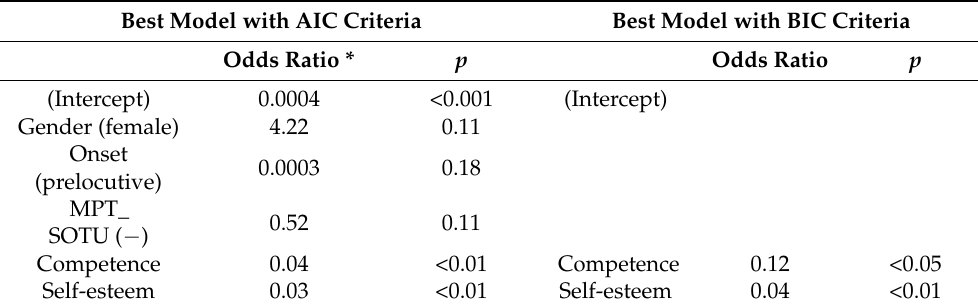
Table 4. Logistic regression coefficients (transformed to odds ratio) for two alternative models to predict abandonment of hearing aids, selected with a best regression procedure using Akaike information criterion (AIC) and Bayesian information criterion (BIC) as goodness-of-fit criteria. Best Model with AIC